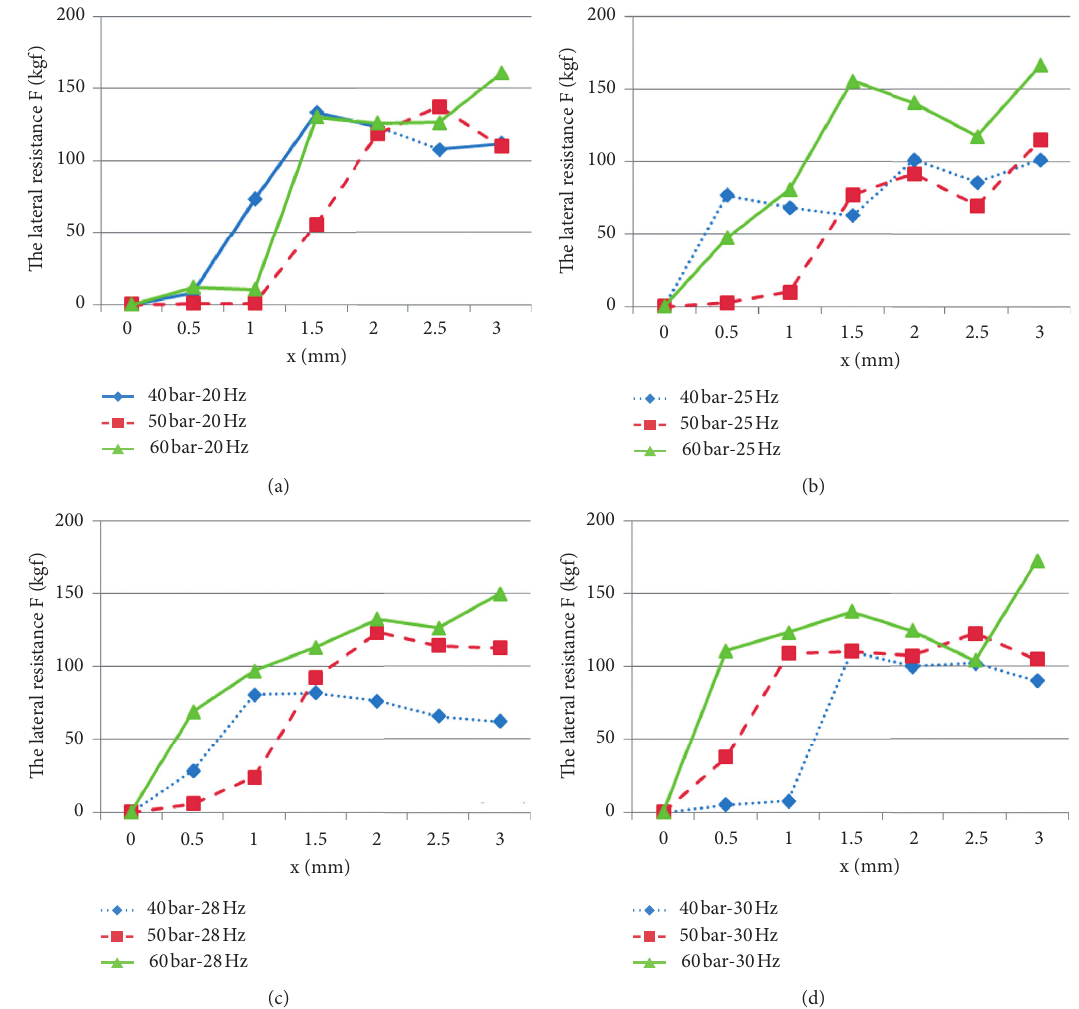
Figure 14: The curve of the lateral resistance under fixed frequencies and different pressures.